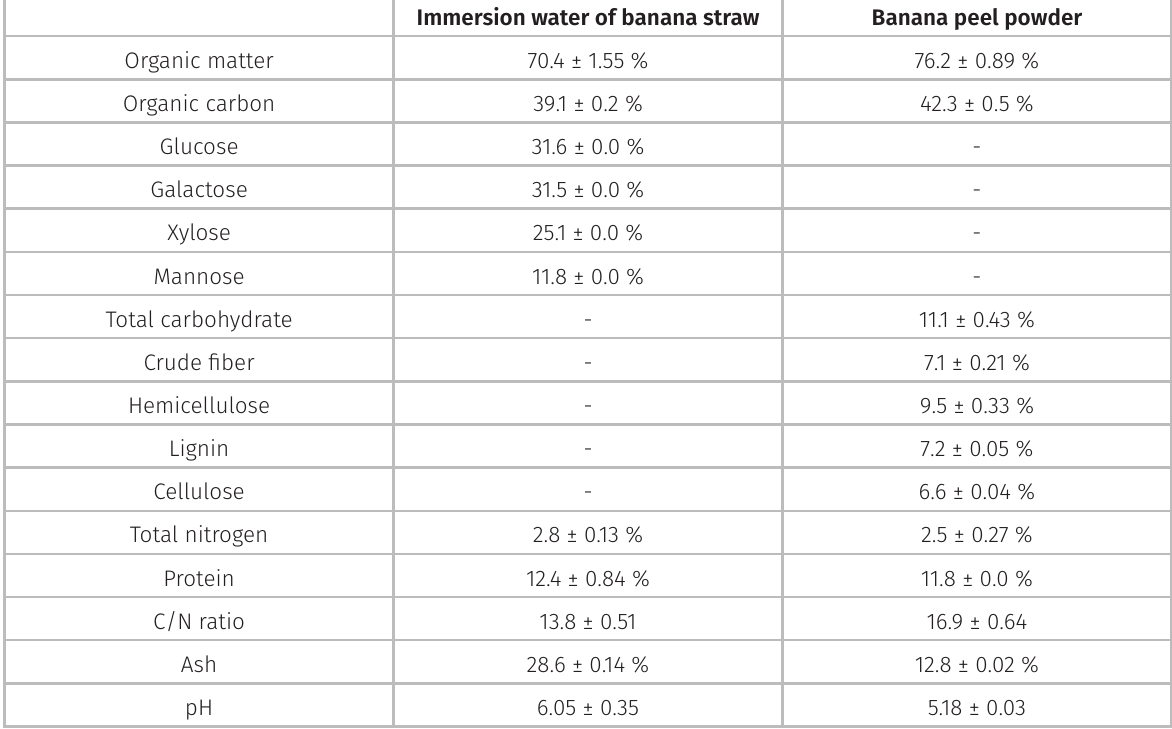
Table I. Chemical composition of banana wastes (mean value ± standard